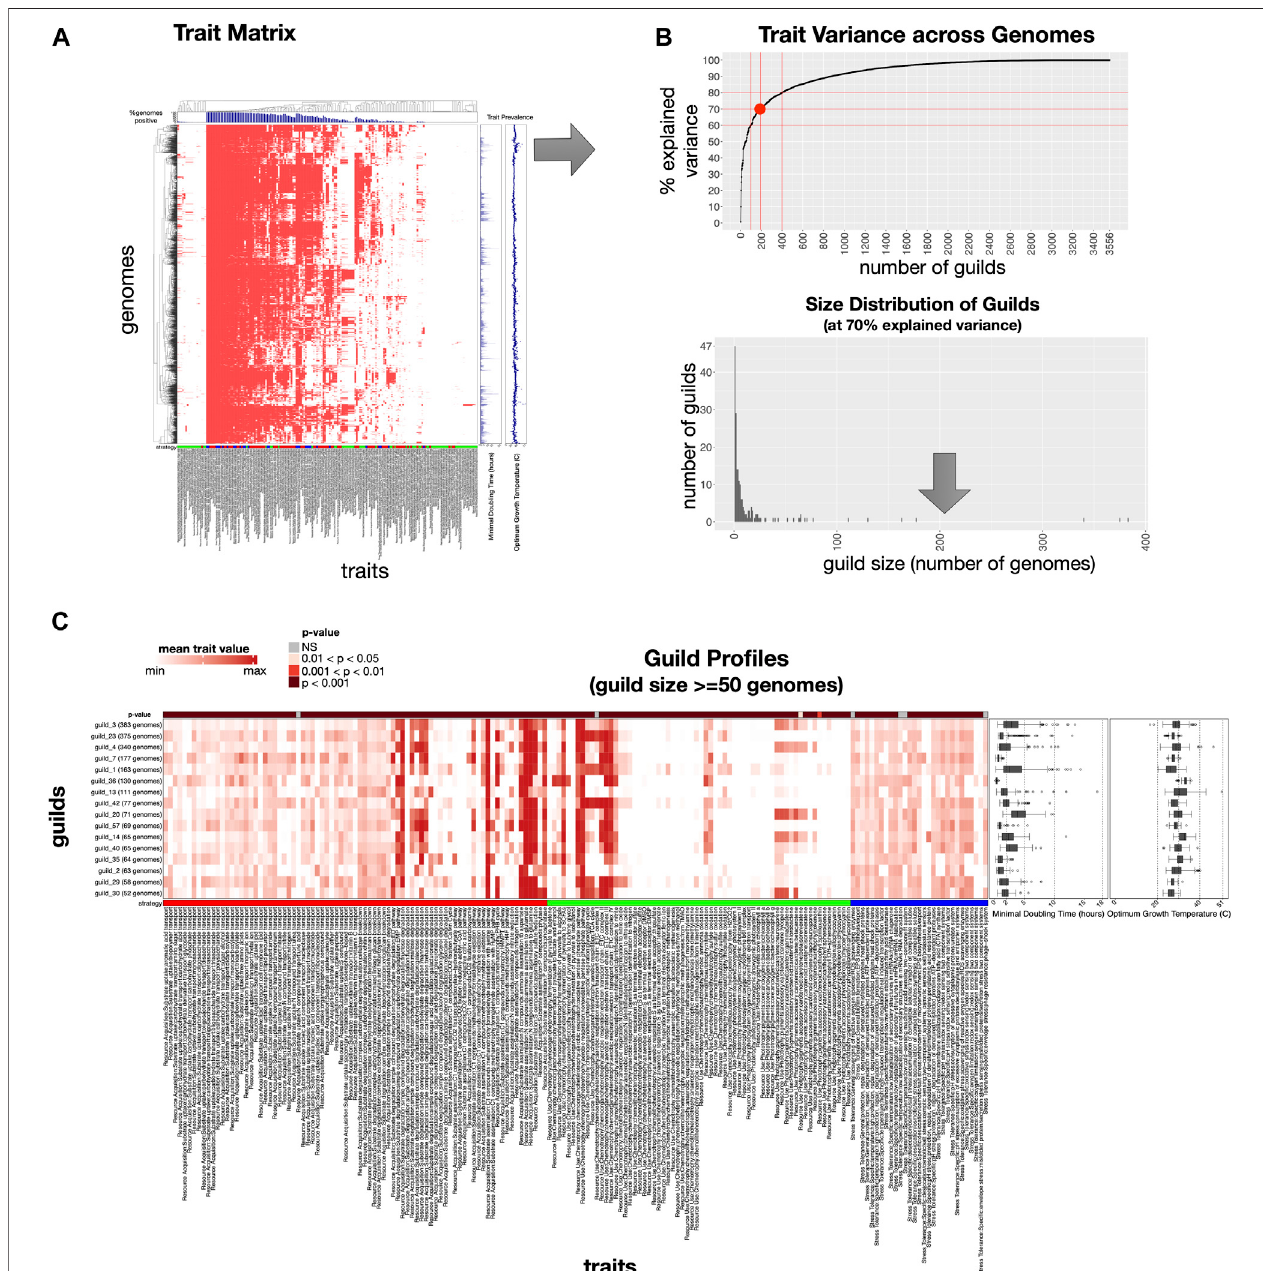
FIGURE 5 | Primary use cases and graphical outputs of microTrait work fl ow. (A) Trait matrix provides clustering of a set of input genomes using trait pro fi les from microTrait outputs based on a distance metric taking into account mixed data types (i.e. for binary and count traits). Heatmap visualization use presence (red)/absence (white)oftraits,withtraitprevalence(%genomespositive)shownatthetoppanel.Lifehistorytraits(minimaldoublingtimeandoptimumgrowthtemperature)areoverlaid on the right panel in continuous scale. (B) Trait variance across genomes based on the genome clustering is quanti fi ed as a function of the number of guilds using analysisofvarianceusingdistancematrices.Guildscanbede fi nedeitherata fi xednumberofguildsorbasedonpercentexplainedwithin-guildvariance,whichresultsin asize(numberofsupportinggenomes)distributionofguilds. (C) Visualizationoftraitpro fi lesforthede fi nedguilds(guilds×traits),withmeantraitvaluesvisualizedacross a color scale. Traits are ordered by ecological strategies (red: resource acquisition, green: resource use, blue: stress tolerance). For each trait, top panel shows the statistical signi fi cance of comparison of mean trait values across guilds. The distribution of life history traits are shown on the right side panels.